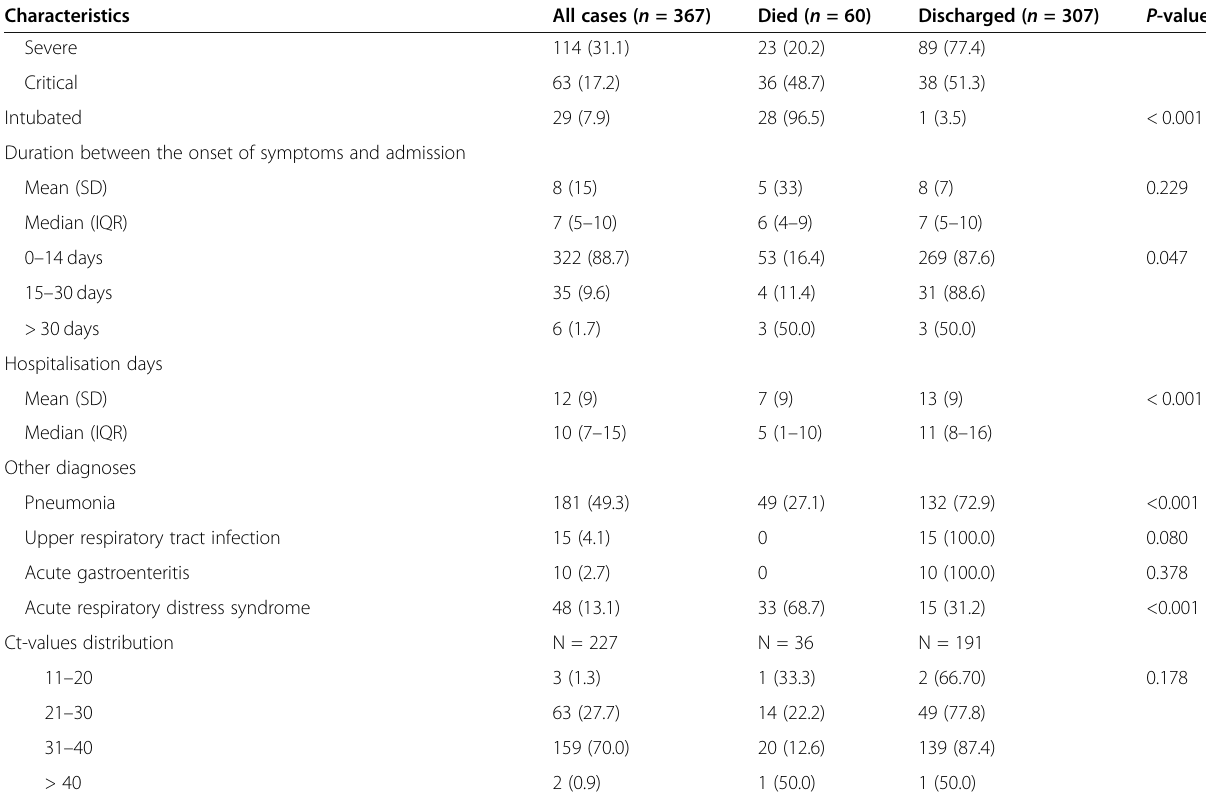
Table 2 Associations with mortality among 367 non-HCW COVID-19 inpatients in San Lazaro Hospital, January to October 2020 (Continued)